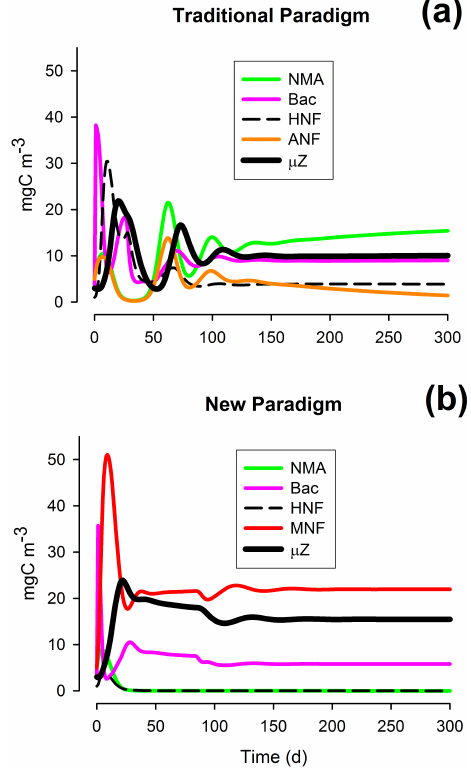
Fig. 3. Temporal pattern of the development of biomass in the simu- lated communities. In the traditional paradigm (A) , the autotrophic nanoflagellates (ANFs) have no mixotrophic potential, while in the new paradigm (B) these nanoflagellates (as MNFs) exhibit mixotro- phy (see also Fig. 2). The inorganic nutrient regimes used for this simulation (with an inorganic N input of 1µM) was Redfield N:P (molar ratio 16).